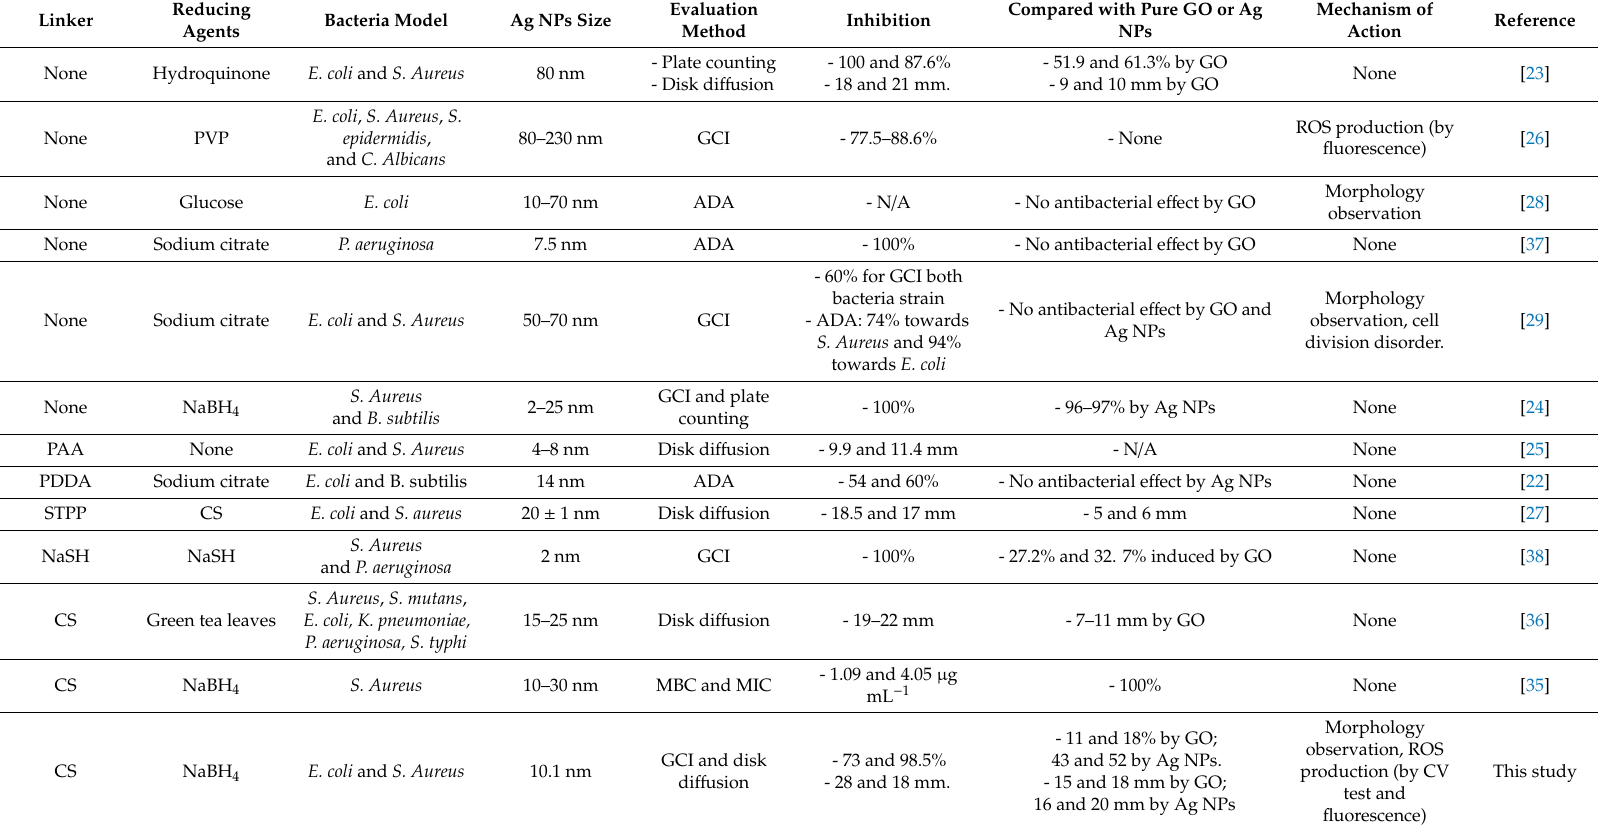
Table 3. Antibacterial e ff ect of GO–Ag